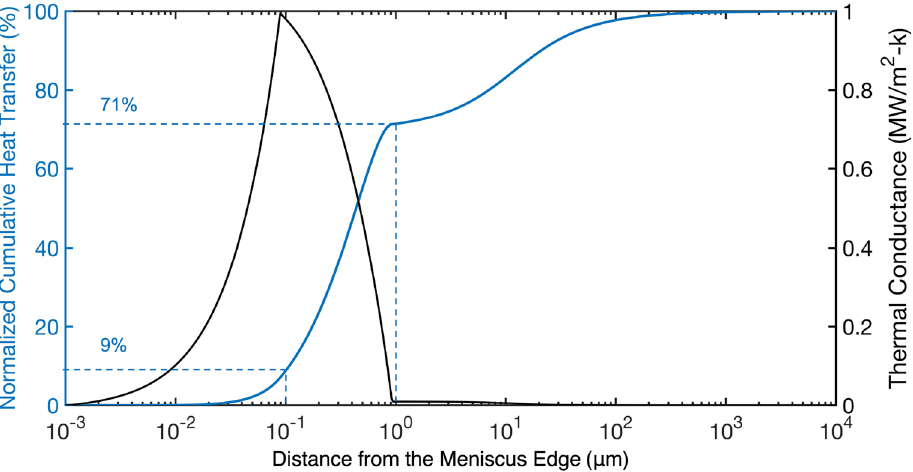
Figure 4. Thermal conductance profile across the meniscus (black line). The blue line shows the normalized cumulative heat transfer. The two vertical dashed lines mark the positions where the distances to the meniscus edge are 0.1 μm and 1 μm. The two horizontal dashed lines show the corresponding normalized cumulative heat transfer percentage, which are 9% and